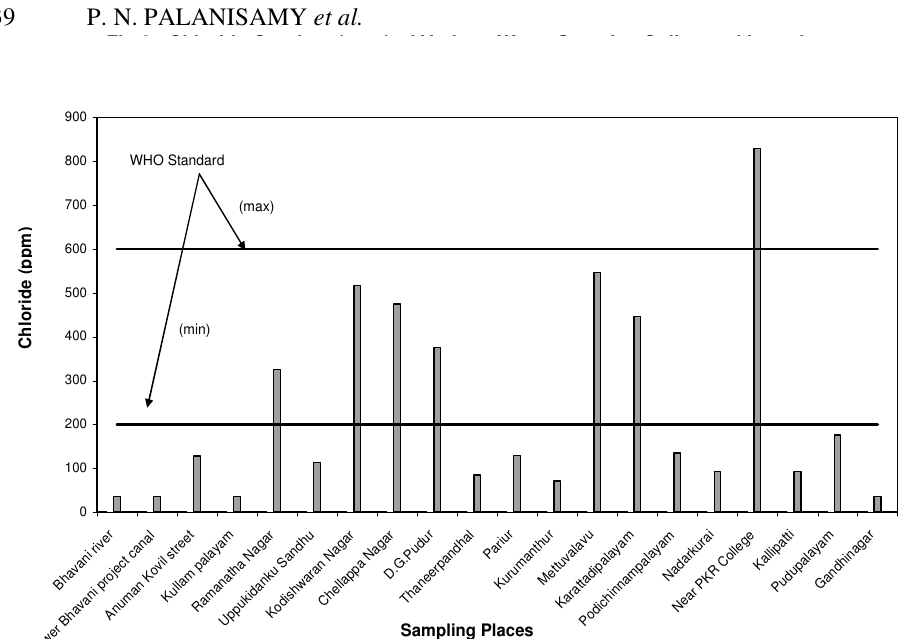
Figure 3. Chloride content(ppm) of various water samples collected in and around Gopichettipalayam